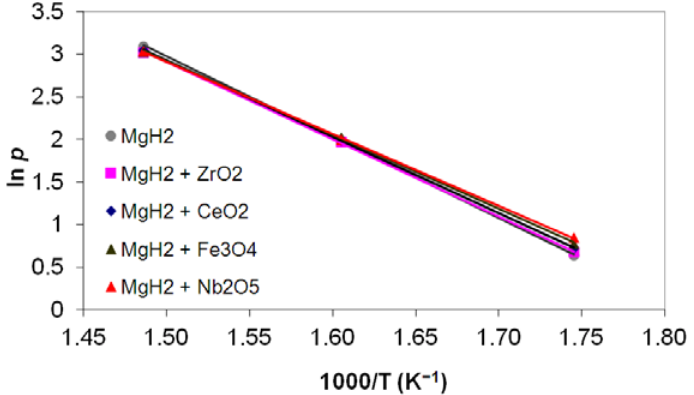
and catalyzed MgH 2 2